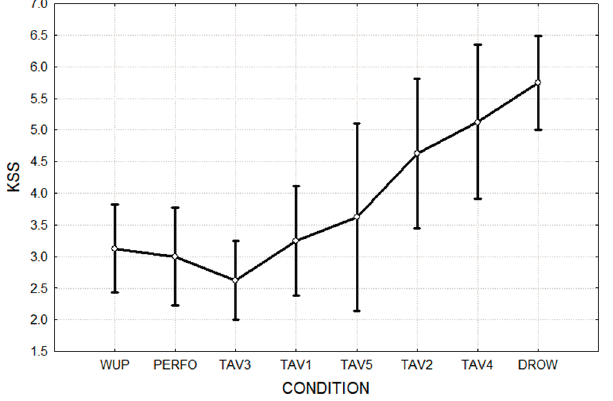
Figure 5. KSS scores related to the different experimental conditions.